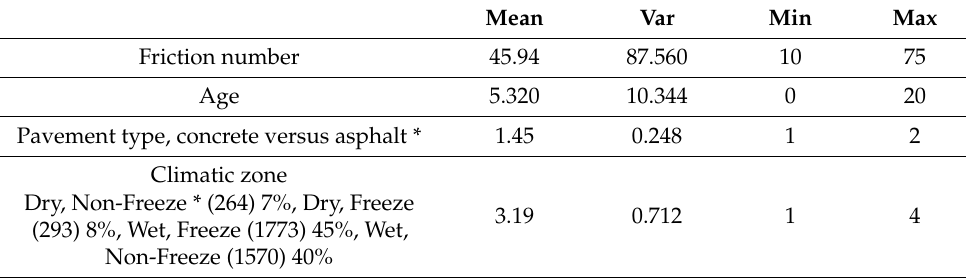
Table 1. Descriptive statistics of important predictors consdierred in the statistical model.